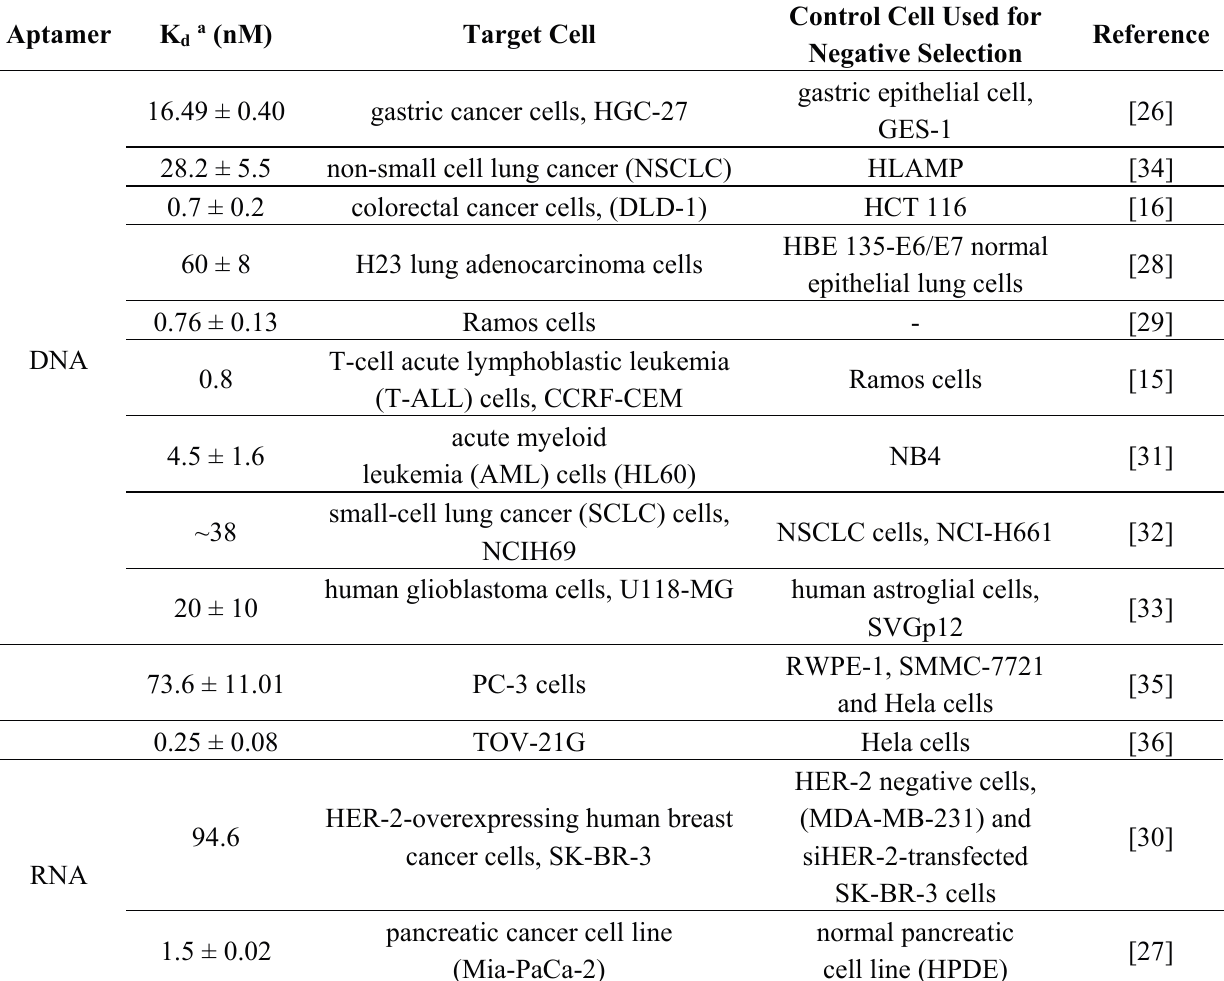
Table 1. Summary of aptamers selected against cancer cells using cell-SELEX.